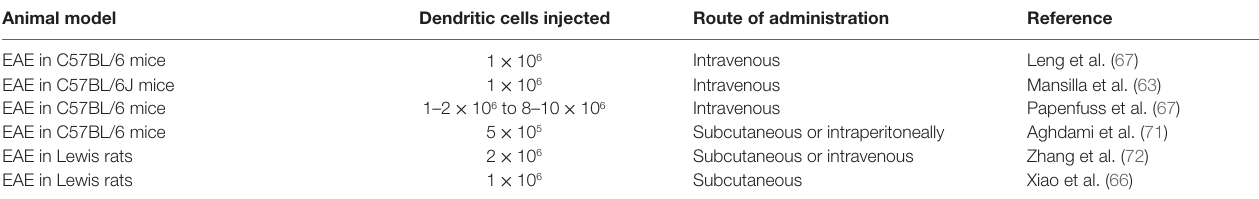
TAble 3 | Summary of tolerogenic DCs therapy in animal models (65, 67, 69,